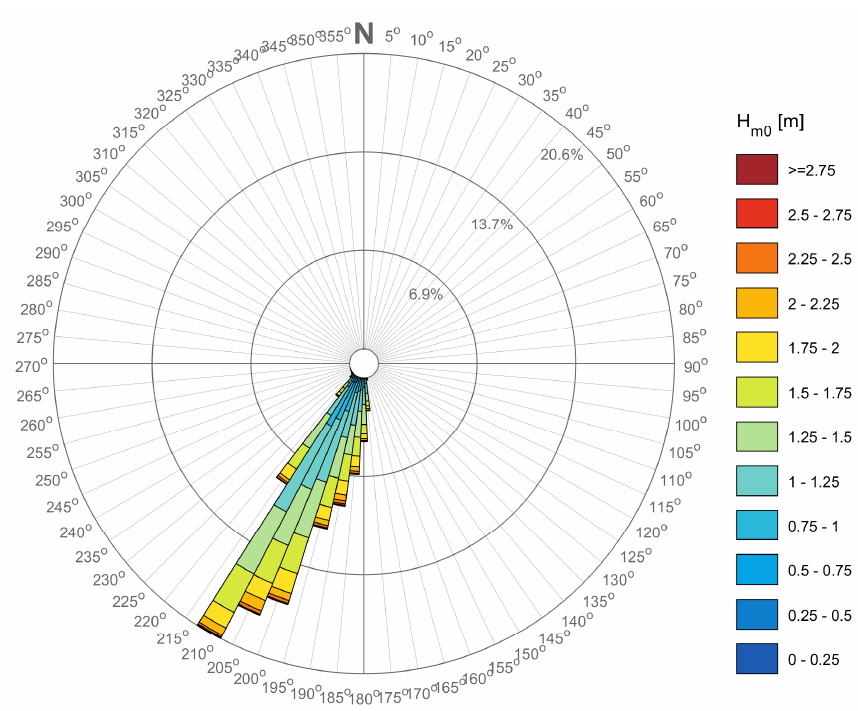
Figure 2. Wave rose based on o ff shore hindcast wave data from the NOAA WAVEWATCH III ®